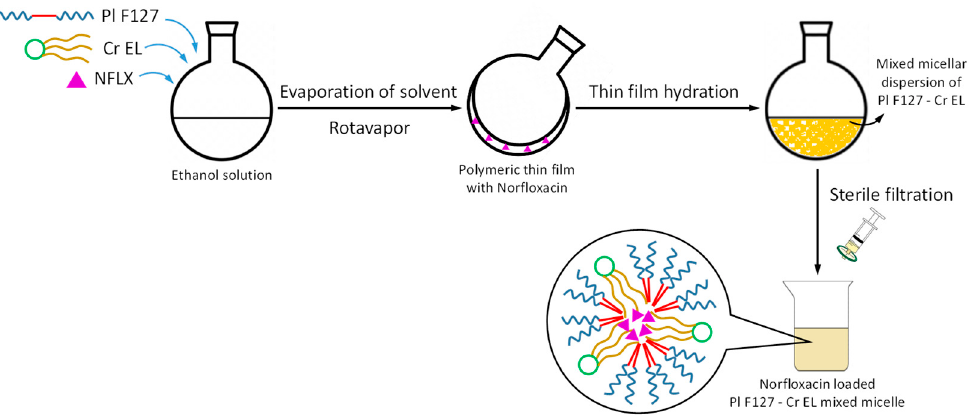
Figure 1. Schematic representation of the obtaining procedure for the Norfloacin loaded Pluronic F127—Cremophor EL mixed micelles.